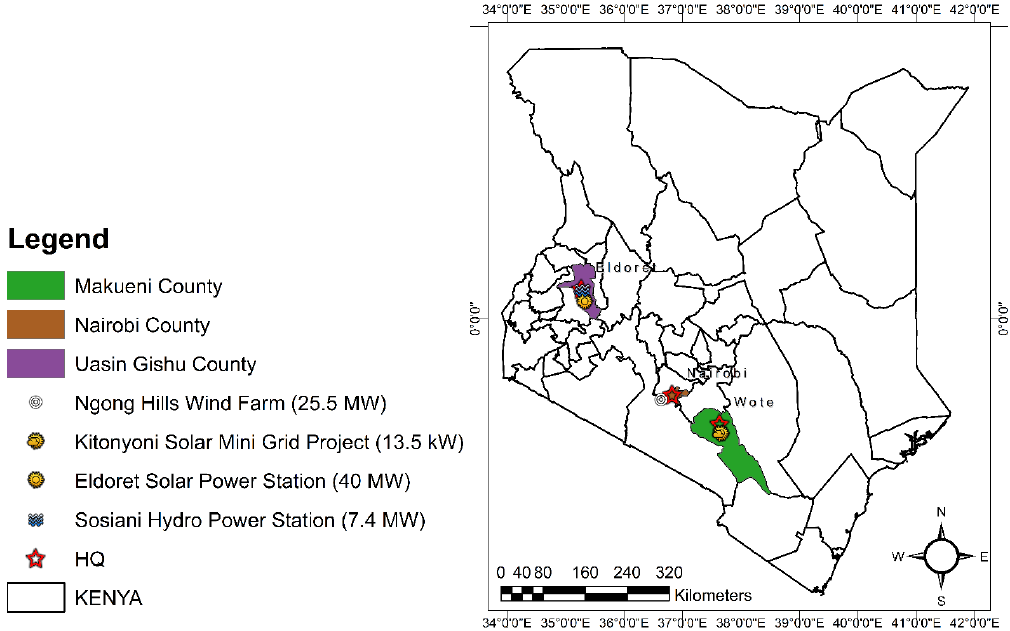
Figure 1. Map showing the study areas Source: Ministry of Devolution and ASAL